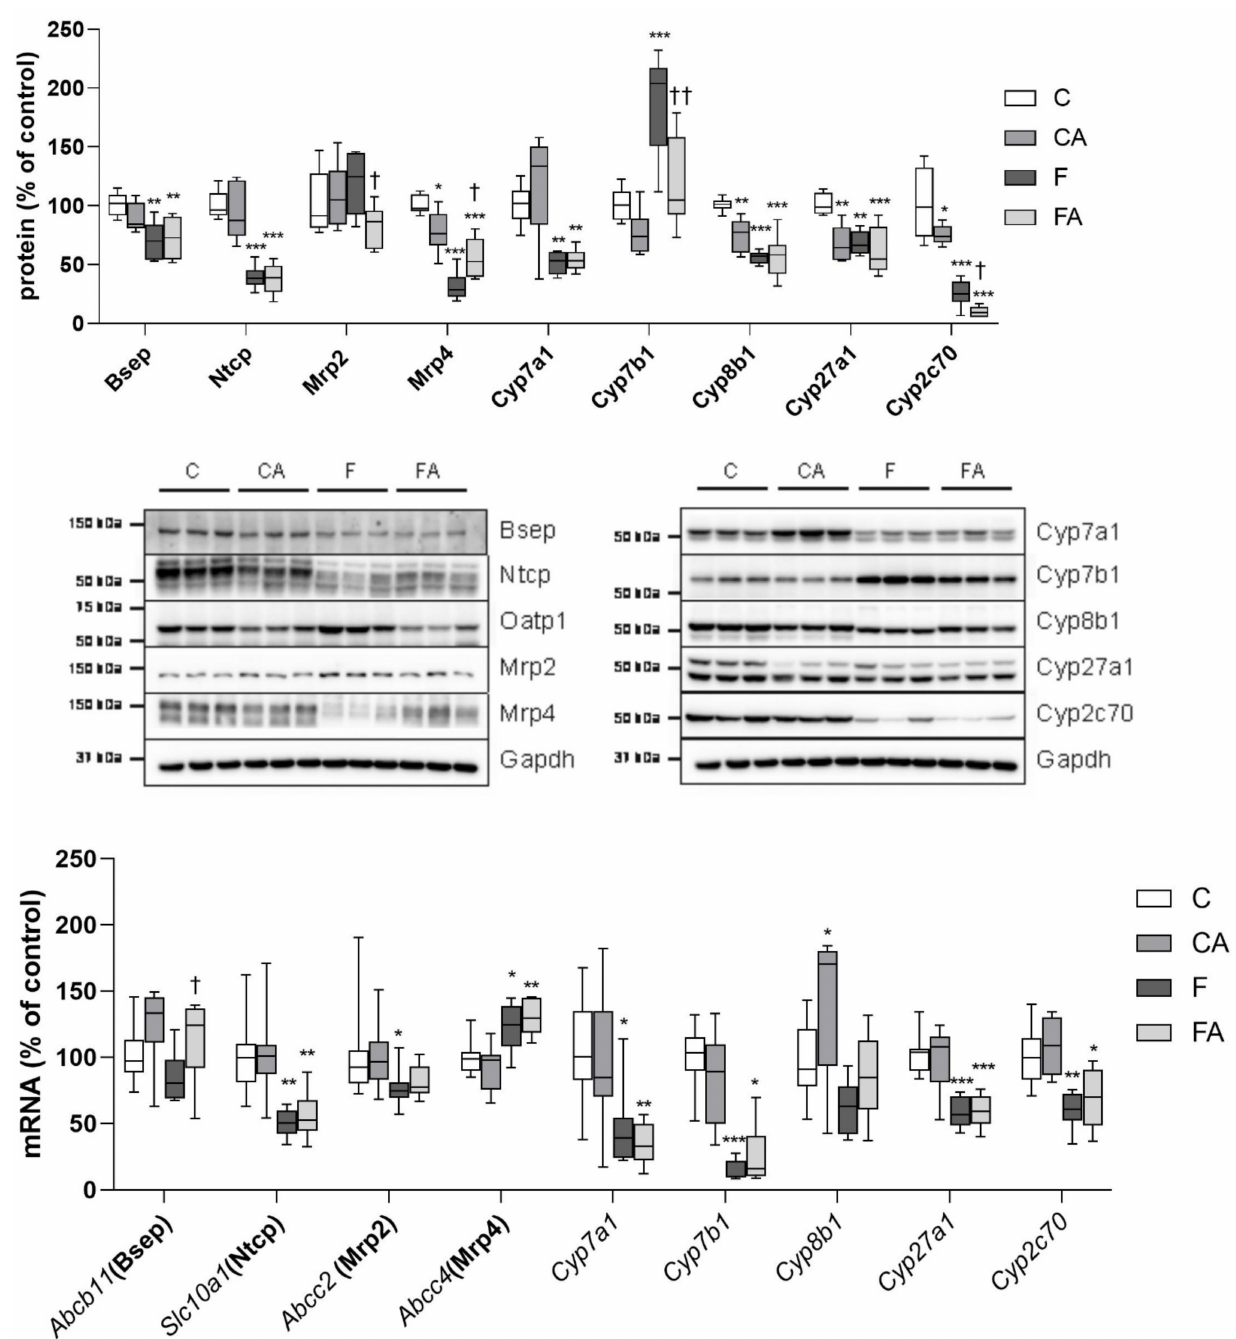
Figure 7. Influence of atorvastatin treatment and F diet consumption on the mRNA and protein expression levels of BA-related genes in the liver. NASH was induced in mice by 24 weeks of an F diet, with atorvastatin (A) administered orally (20 mg/kg/day) during the last three weeks. Corresponding control groups received a chow (C) diet. Data are presented as median values, with boxes and whiskers representing the interquartile range and fifth to 95th percentiles, respectively. * p < 0.01, ** p < 0.01, and *** p < 0.001 atorvastatin and/or F-diet vs. vehicle-administered chow diet–treated mice; † p < 0.05 and †† p < 0.01 atorvastatin-treated vs. vehicle-treated NASH